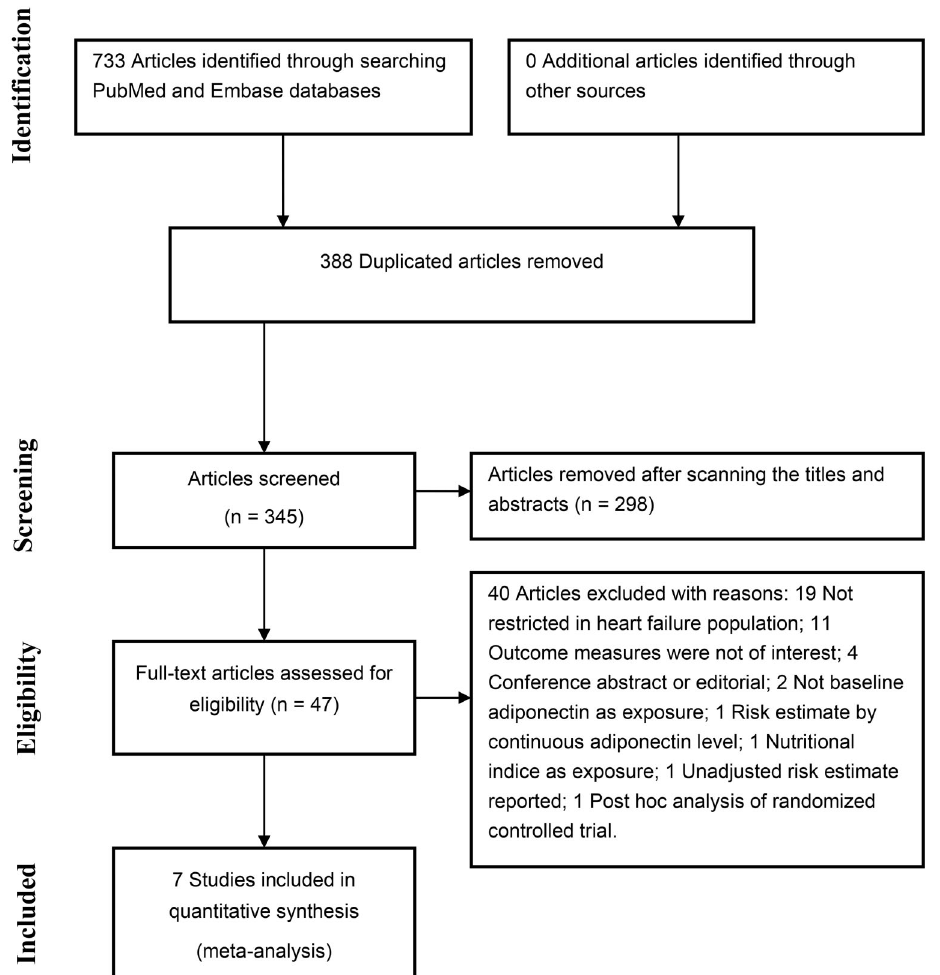
Figure 1. Flow chart of the study selection